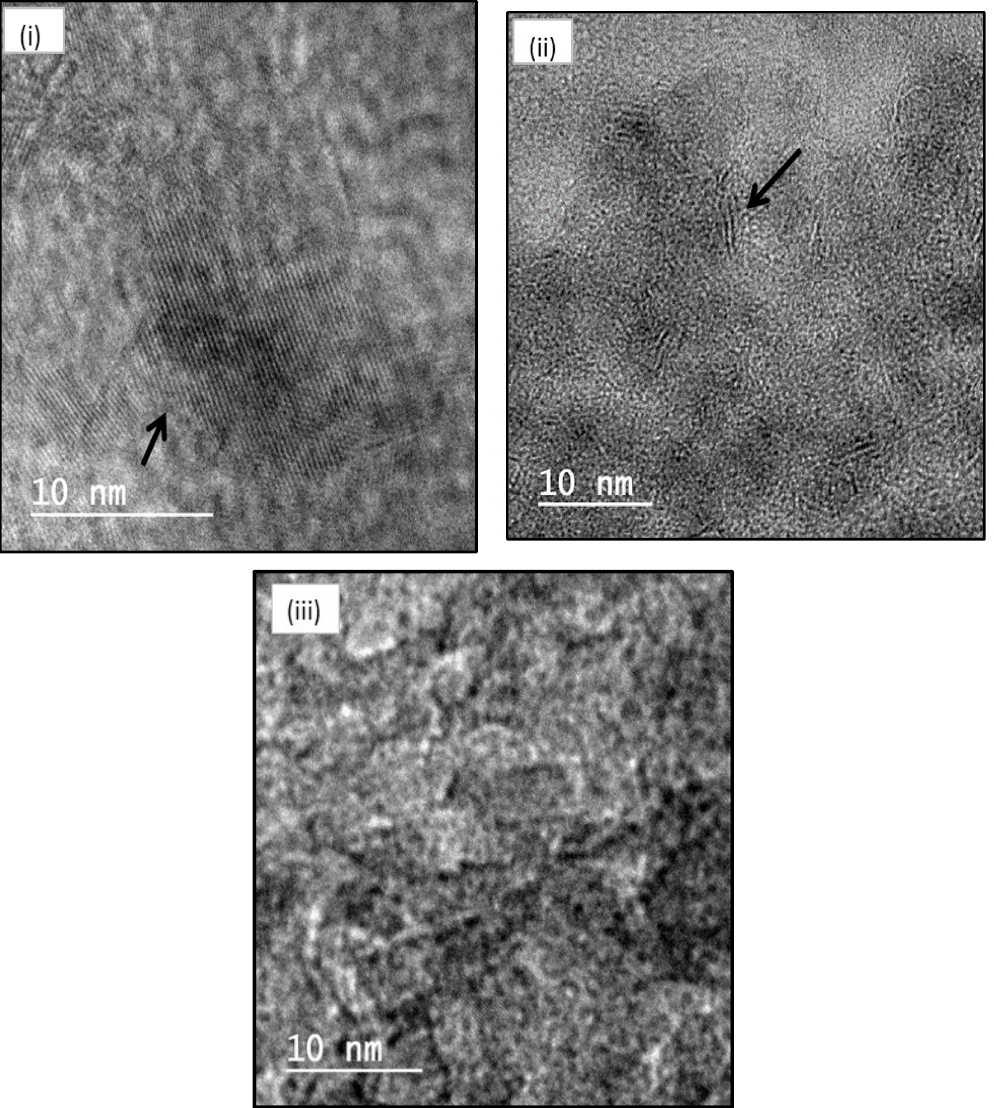
Figure 4. Transmission electron microscopy (TEM) images of the prepared NiMo catalysts ( i ) NiMo / AC, ( ii ) NiMo / Al 2 O 3 , and ( iii ) NiMo / SBA 15 (arrow shows the presence of MoS 2 ).